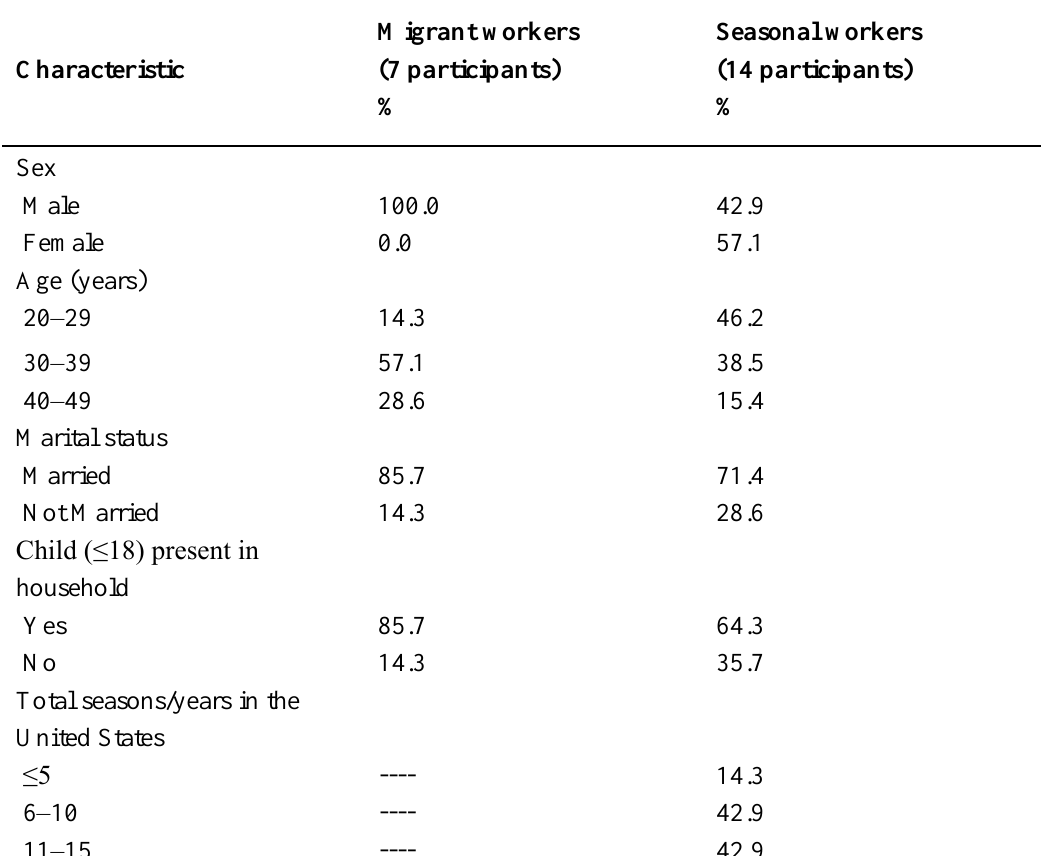
Table 1. Demographic characteristics of focus groups